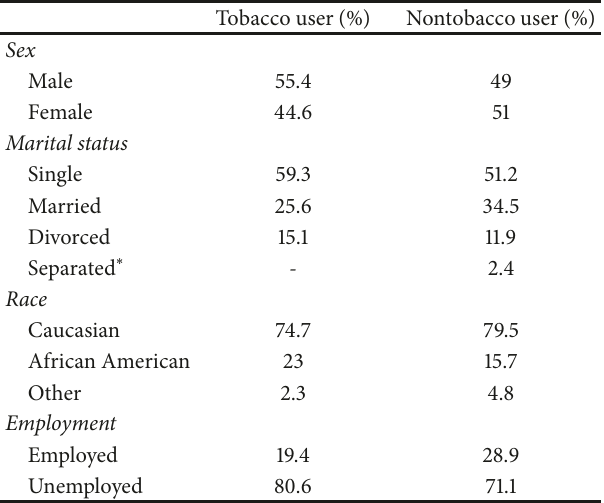
Table 1: Demographic breakdown of